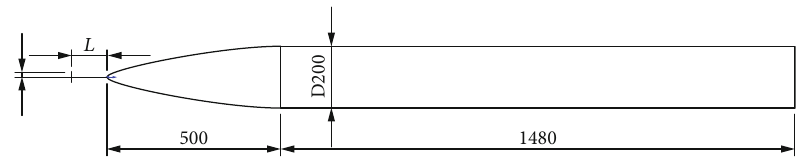
Figure 5: Carmen curve bodies with aerospike (unit: millimeter).